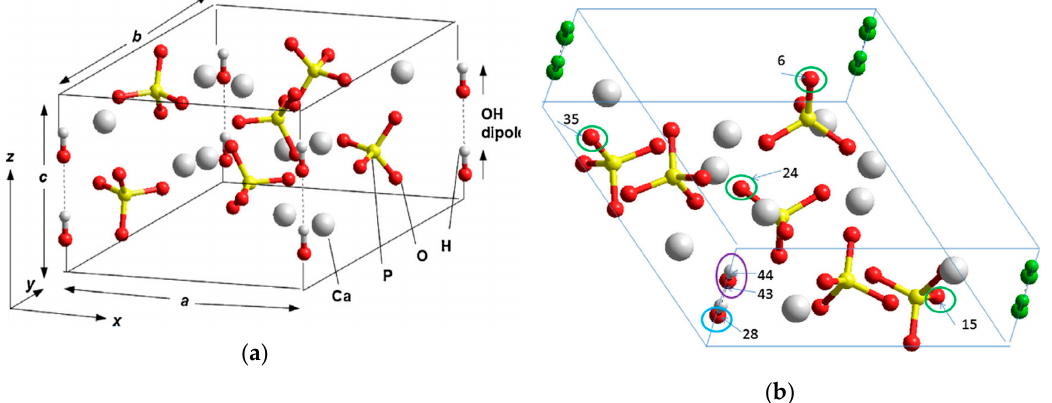
Figure 10. ( a ) HAp unit cell of hexagonal P6 3 [22,23]. ( b ) Schematic of the atoms selected for modelling of various vacancy defects in the HAp hexagonal unit cell with 44 atoms [28]. Indicated are: (1) in blue—oxygen atom number 28 from an OH group for creation of an O vacancy in the OH-channel; (2) in purple—OH group with atom numbers 43 and 44 for creation of a complete OH vacancy; (3) in green—oxygen atoms with numbers 6, 15, 24, and 35 from various differently positioned PO 4 groups corresponding to an O vacancy in PO 4 groups [22,28].